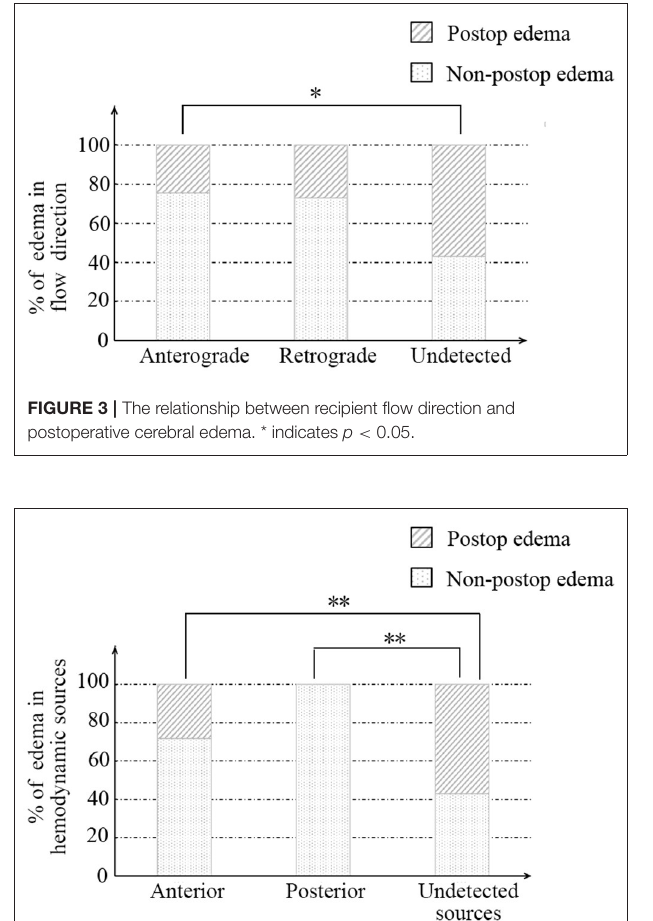
Multiple applications have focused on recipient vessel selection to reduce acute complications via intraoperative indocyanine green video angiography, which indicated the earliest emission was prone to occur symptomatic hyperperfusion, and the latest was related to white thrombus of anastomotic sites (5, 7, 21).